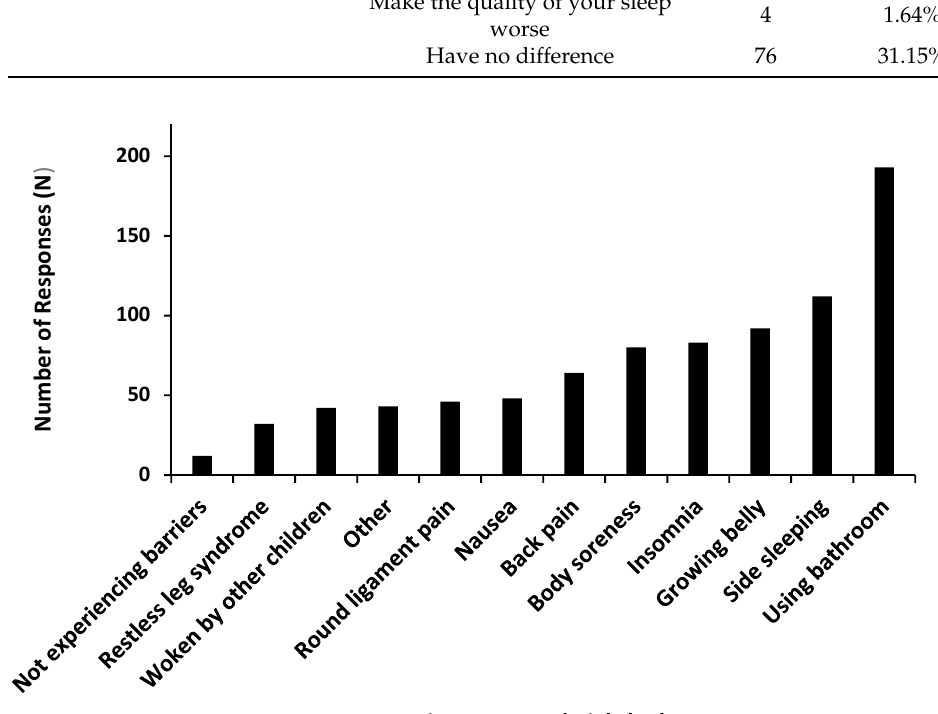
Figure 1. Participants’ reported barriers to sleep in their current